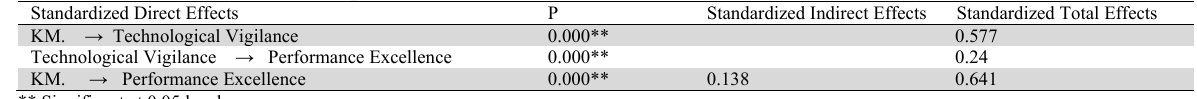
Estimates for direct and indirect impact Standardized Direct